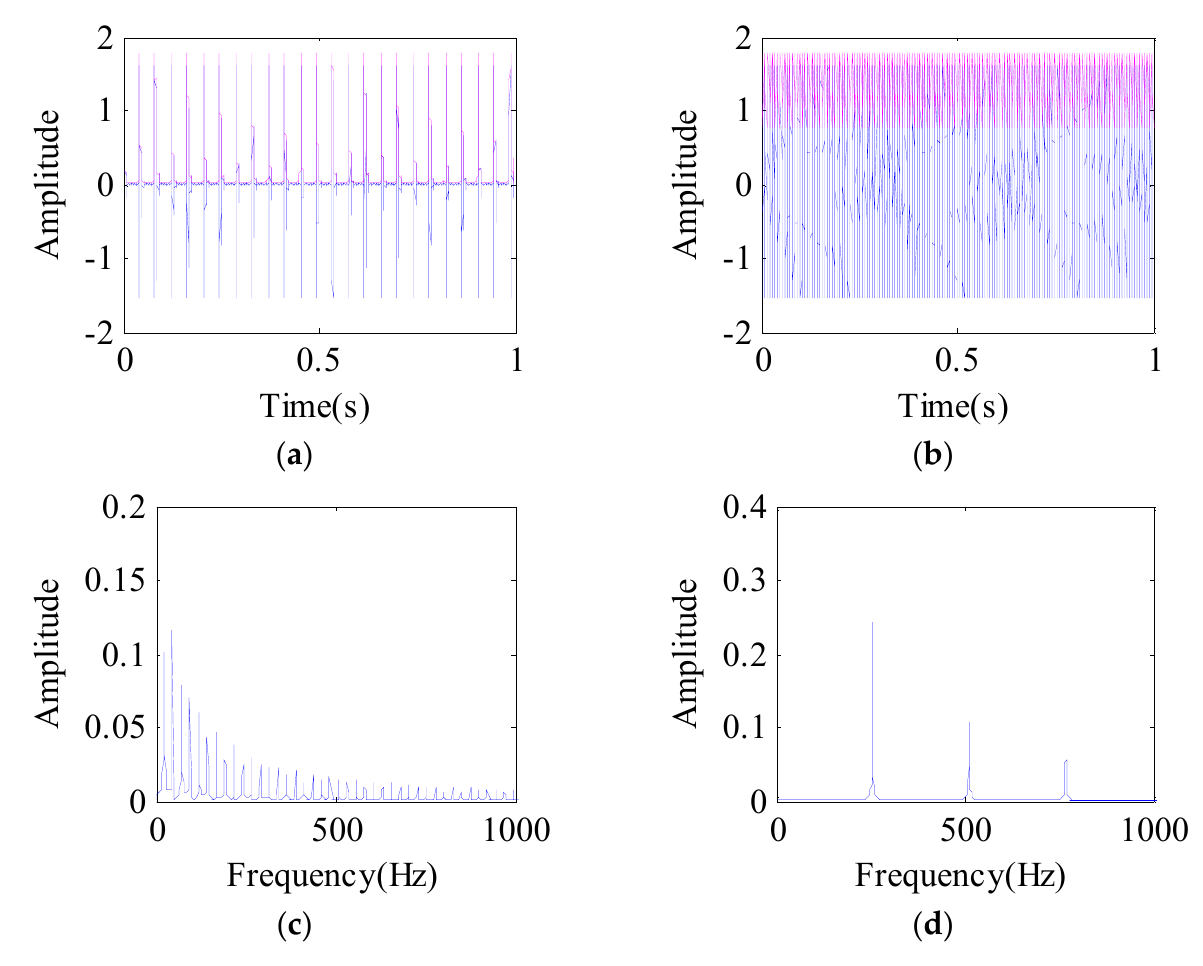
Figure 4. Fault characteristic frequency of axle box bearing at different speeds: ( a ) time domain diagram of outer ring fault characteristic frequency of 24.3 Hz; ( b ) time domain diagram of outer ring fault characteristic frequency of 255.5 Hz; ( c ) envelope spectrum of outer ring fault characteristic frequency of 24.3 Hz; ( d ) envelope spectrum of outer ring fault characteristic frequency of 255.5 Hz.